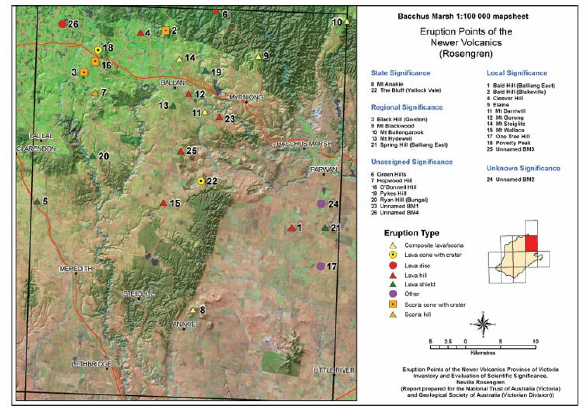
Figure 2. Example image map with 3D relief and air photo